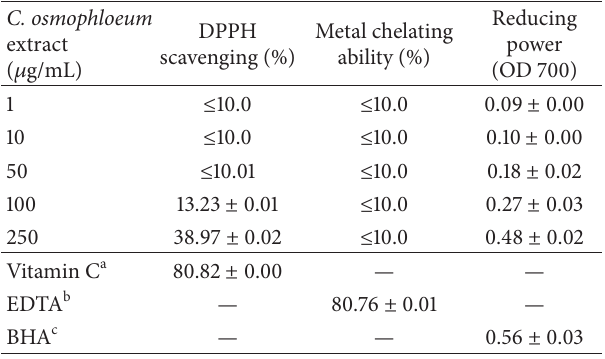
Table 1: Measurement of C. osmophloeum extracts on antioxidant experiments. The data were expressed as a mean value in three independent